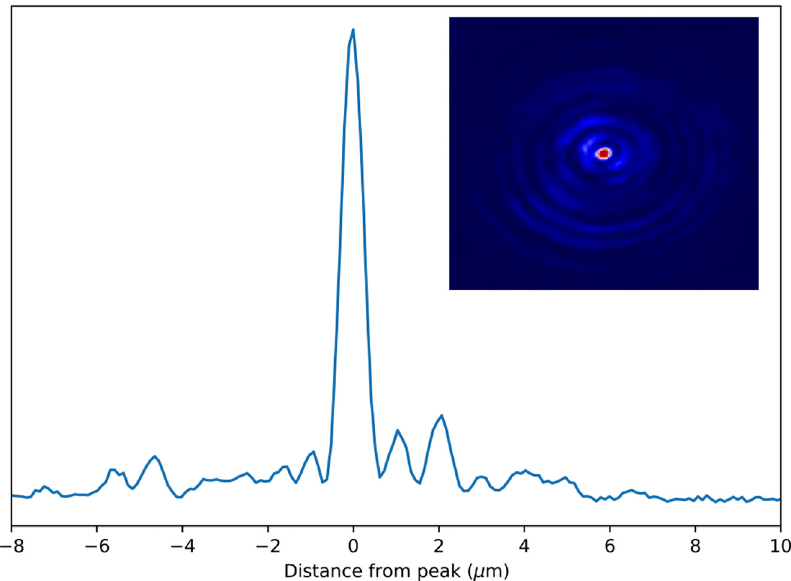
Figure 8: Radial intensity profile corresponding to the transverse profile of the generated nondiffracting beam